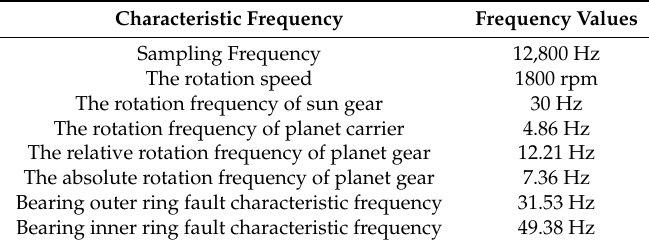
Table 2. Parameters for failure experiment system.